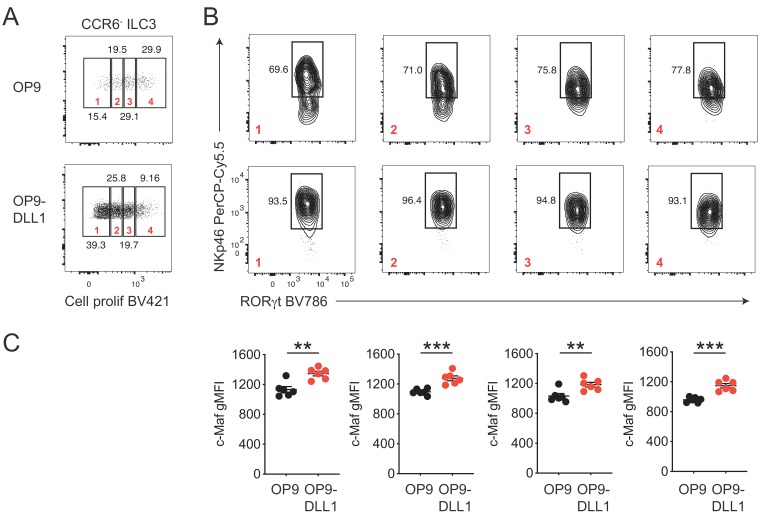
Notch signaling maintains NKp46 and c-Maf expression in NKp46+ CCR6- ILC3s independent of cell proliferation.(A) Small intestinal NKp46+ CCR6- ILC3s were FACS-purified, labeled with a cell proliferation dye and cultured on OP9 or OP9-DLL1 feeder cells for 12 days. Representative dot plots show cell proliferation dye dilution (pre-gated on CCR6- ILC3s). Gates 1 to 4 indicate different generations of proliferating cells. (B) Representative contour plots showing NKp46 expression by distinct generations of OP9 or OP9-DLL1 cultured NKp46+ CCR6- ILC3s (gates 1 to 4). (C) Quantitative comparison of c-Maf expression (gMFI) within different generations (gates 1 to 4) of OP9 vs. OP9-DLL1 cultured NKp46+ CCR6- ILC3s (gates 1 to 4; n = 6, mean ± SEM, **p<0.01, ***p<0.001). Statistical differences were tested using an unpaired Students’ t-test (two-tailed).